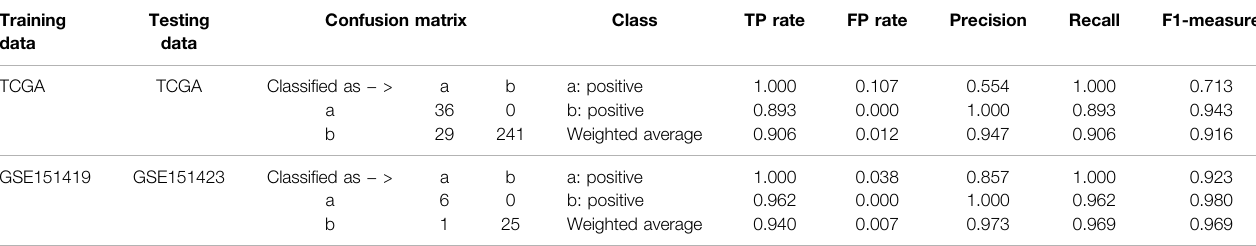
TABLE 3 | Quantitative results on TCGA and GSE151423 using miR-140, miR-570, and miR-210. Training